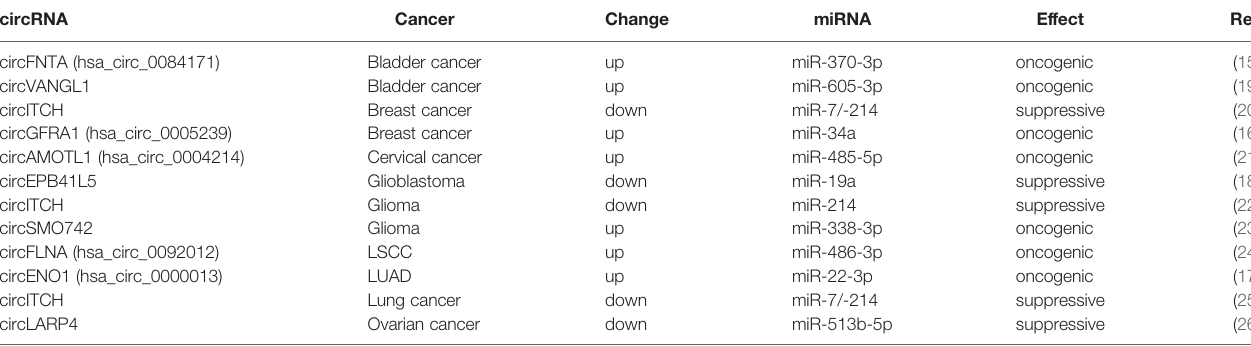
TABLE 1 | circRNAs regulate host gene expression as miRNA sponges in human cancer.